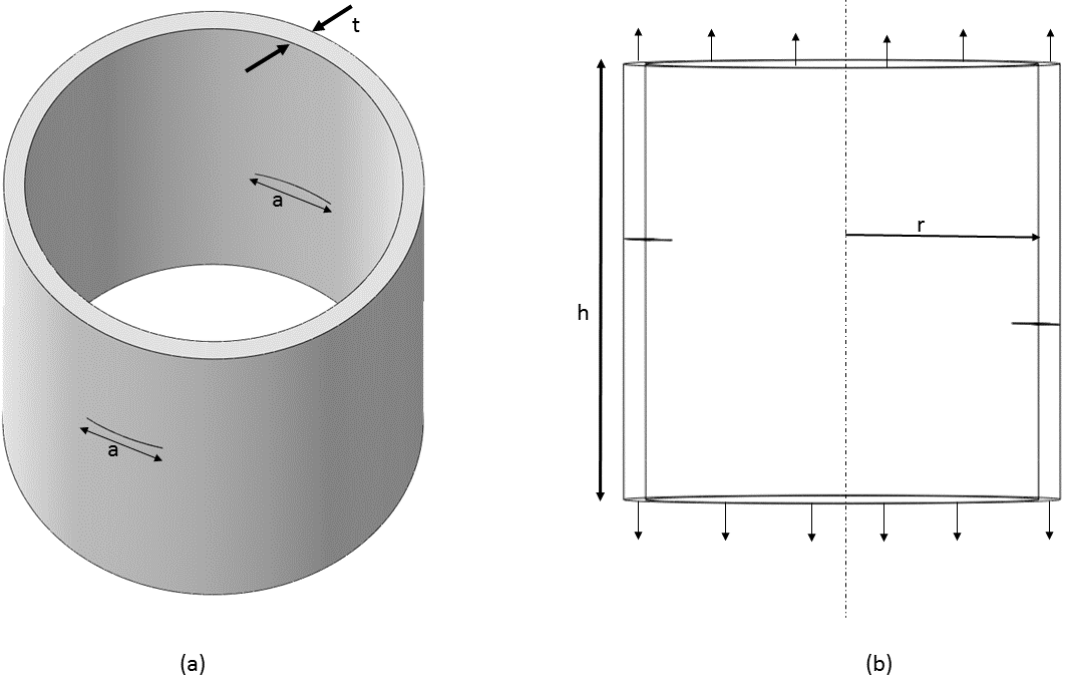
Figure 14. Crack propagation in a thick-walled cylinder: ( a ) isometric view of the cylinder; and ( b ) relative position of the two Cracks.